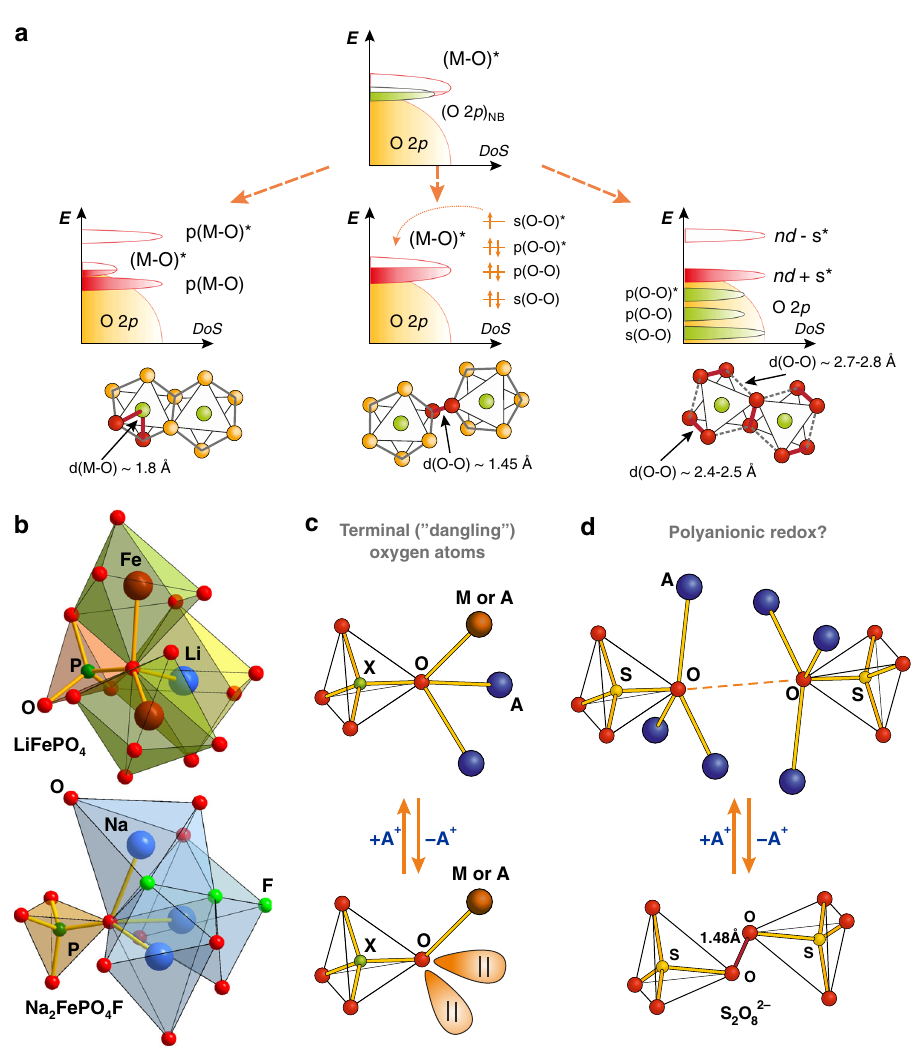
Fig. 2 Anionic redox in metal-ion battery cathodes. a Stabilization of oxidized oxygen species (from left to right): strengthening of the M – O π -bonds, catenation of oxygens in the (O – O) 2 − peroxogroups and cooperative distortion of the anionic framework due to a reductive coupling mechanism. sp 3 - Hybridized oxygen orbitals as lone pairs in the polyanion cathode structures: b Local coordination environment of selected oxygens in the LiFePO 4 and Na 2 FePO 4 F structures. c Deintercalation of two neighbouring A + alkali cations from the oxo-centered tetrahedron leaves two lone electron pairs residing on the O atom at the center of this tetrahedron. d Con fi guration with two oxo-centered tetrahedra linked to sulfate groups and formation of peroxodisulfate anion S 2 O 8 2 − upon deintercalation of the A +